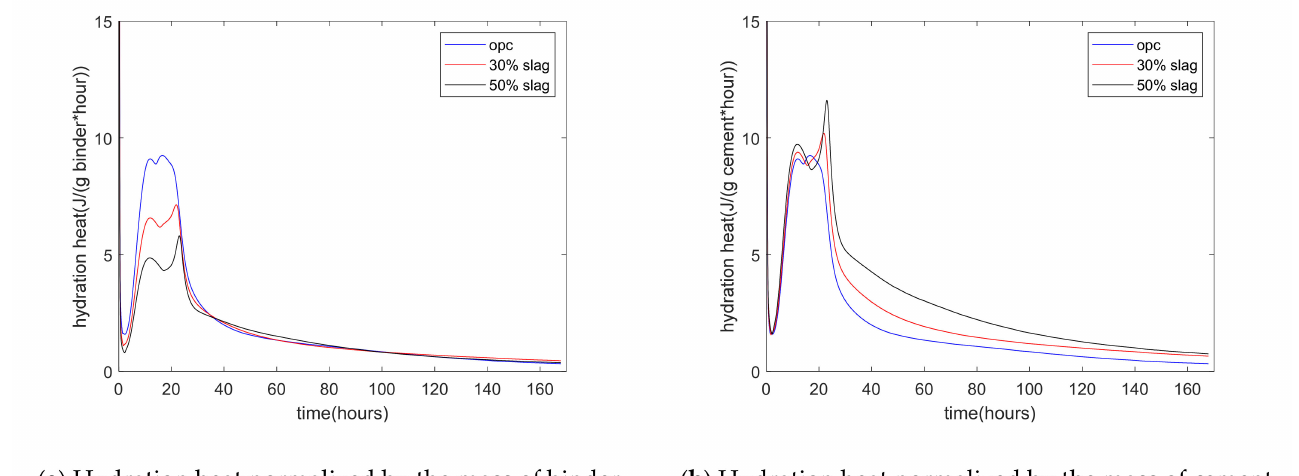
Figure 2. Hydration heat of